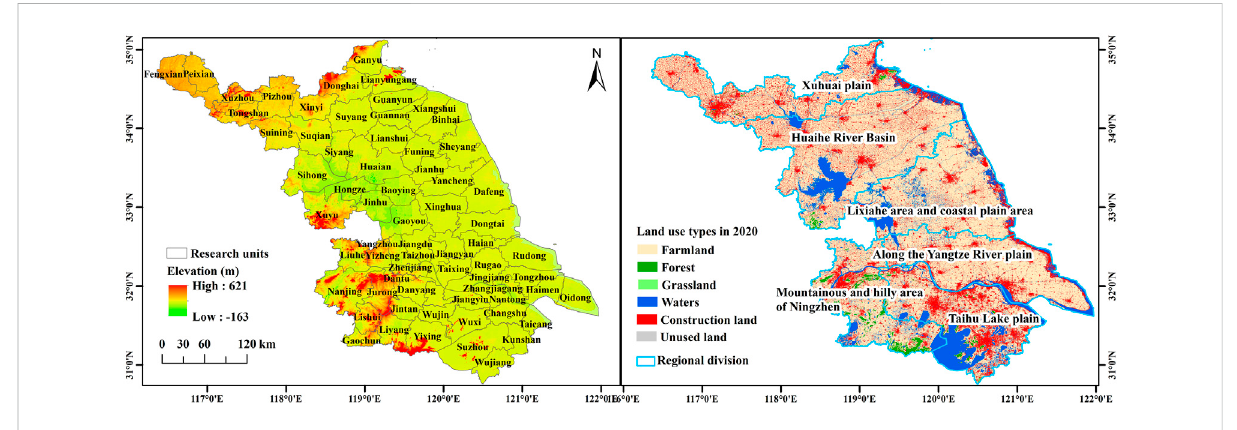
FIGURE 1 Geographical location and land use/land cover map of Jiangsu Province,